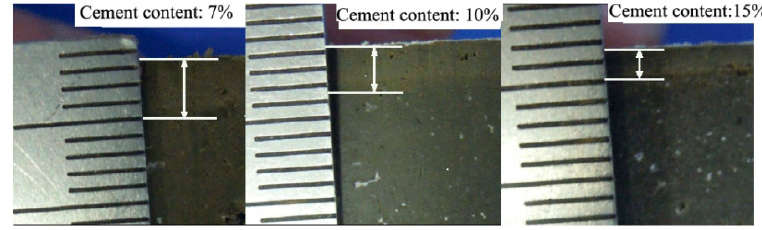
Figure 7. Axial section of the specimen maintained in seawater with a 90-day curing age.